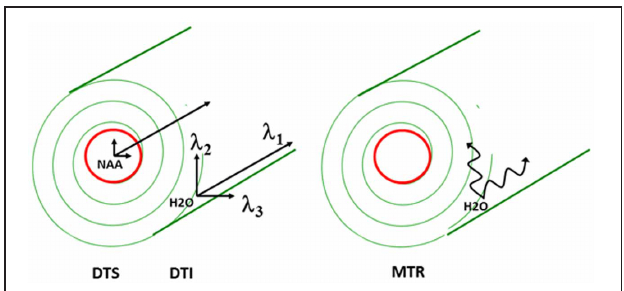
FIGURE 1 | Schematic of proposed white matter measures.